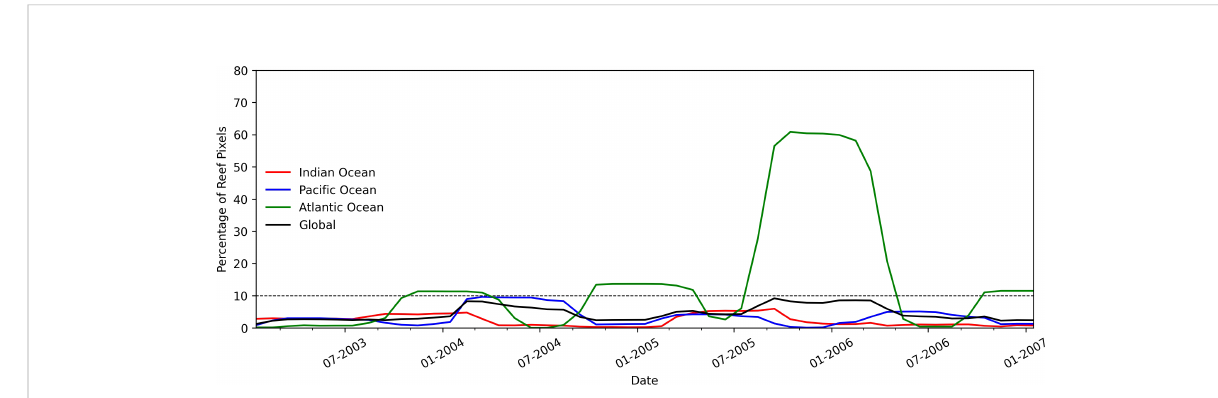
FIGURE 8 Percentage of reef pixels above or equal to the DHW threshold of 4°C-week from 2003 to 2007 with a four-month detection window showcasing the 2005 Caribbean Regional Bleaching